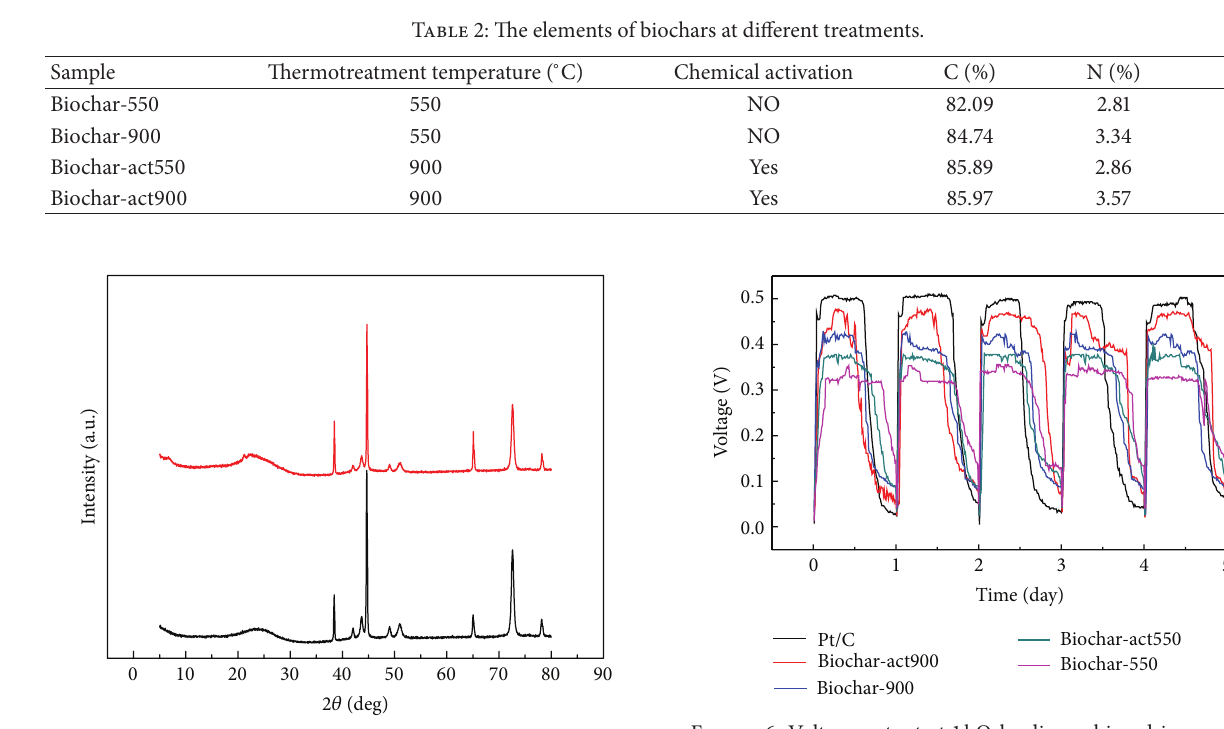
Figure 6: Voltage output at 1k Ω loading achieved in consecutive electricity generation